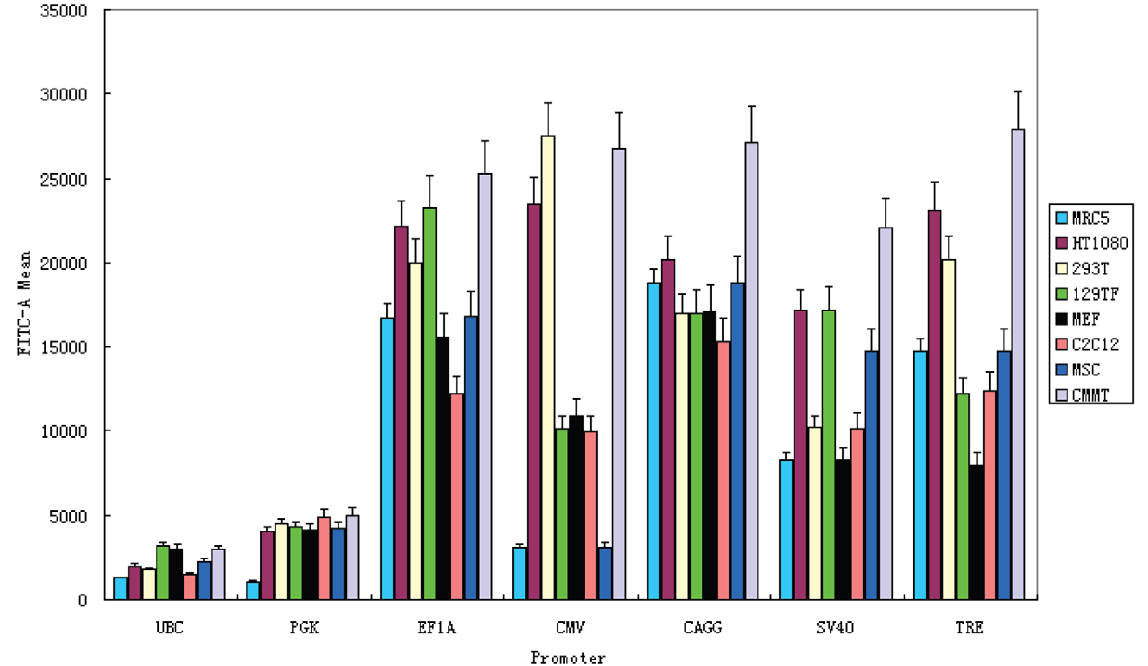
Figure 1. Flow cytometry measurement of GFP fluorescence in eight mammalian cell types transduced with lentiviral vectors carrying GFP reporter driven by promoters of interest. Six mammalian constitutive promoters were tested, along with the doxycycline- inducible TRE promoter at maximal induction.